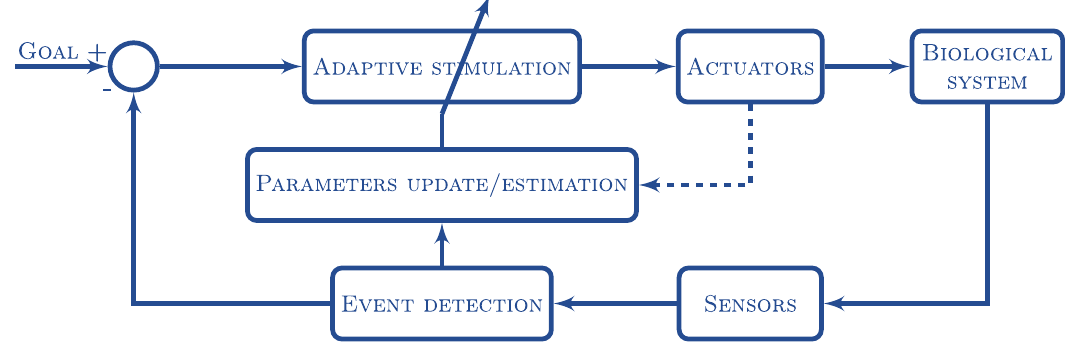
Figure 1. Schematic representation of the goal-driven closed-loop for the activity-dependent stimulation used in the three examples discussed in this paper. The activity of the biological system is monitored through a set of sensors (e.g. microelectrodes, cameras). A given goal drives the detection of specific events that are used to control the adaptive stimulation (through specific actuators) that will lead to this goal. Simultaneously, the output of the event detection and the stimulation can be used for identification purposes by updating or estimating the parameters that control this loop. Examples of goals for the closed-loop interaction are to exert control, reveal or characterize the dynamics, or to achieve the automation of a experiment as we illustrate in the next sections.